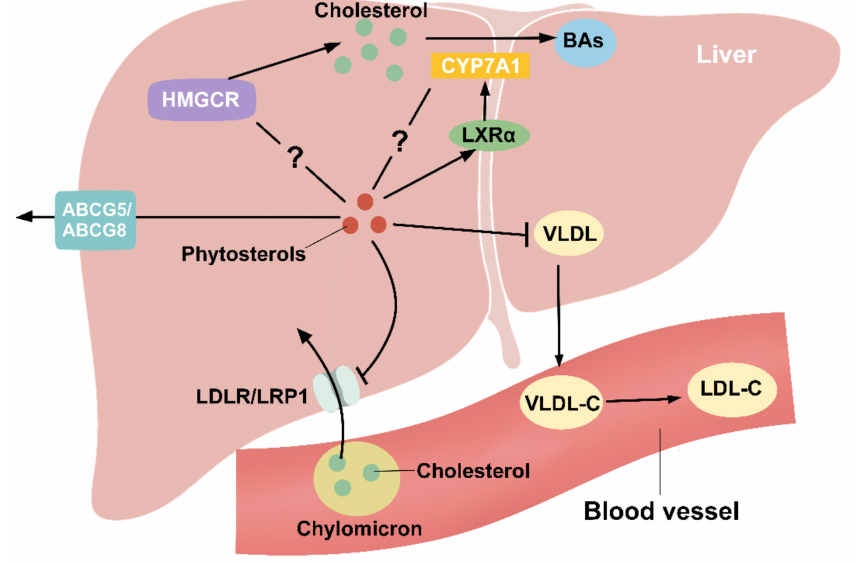
Figure 4. Phytosterols regulate hepatic cholesterol metabolism. Cholesterol in the remnants of chylomicron enters the liver through the action of LDLR and LRP1, which is effectively inhibited by PS. The specific mechanism of phytosterol regulation of HMGCR, a key rate-limiting enzyme for cholesterol synthesis, is unclear. Cholesterol is converted to BAs in the liver by CYP7A1, and LXR α is an upstream regulatory gene of CYP7A1. PS can promote LXR α expression, but the regulatory role for CYP7A1 is controversial. VLDL produced by the liver can be converted to LDL-C in the blood vessels, and PS can decrease hepatic VLDL production to reduce circulating LDL-C levels. PS can also be secreted into the bile via ABCG5/8